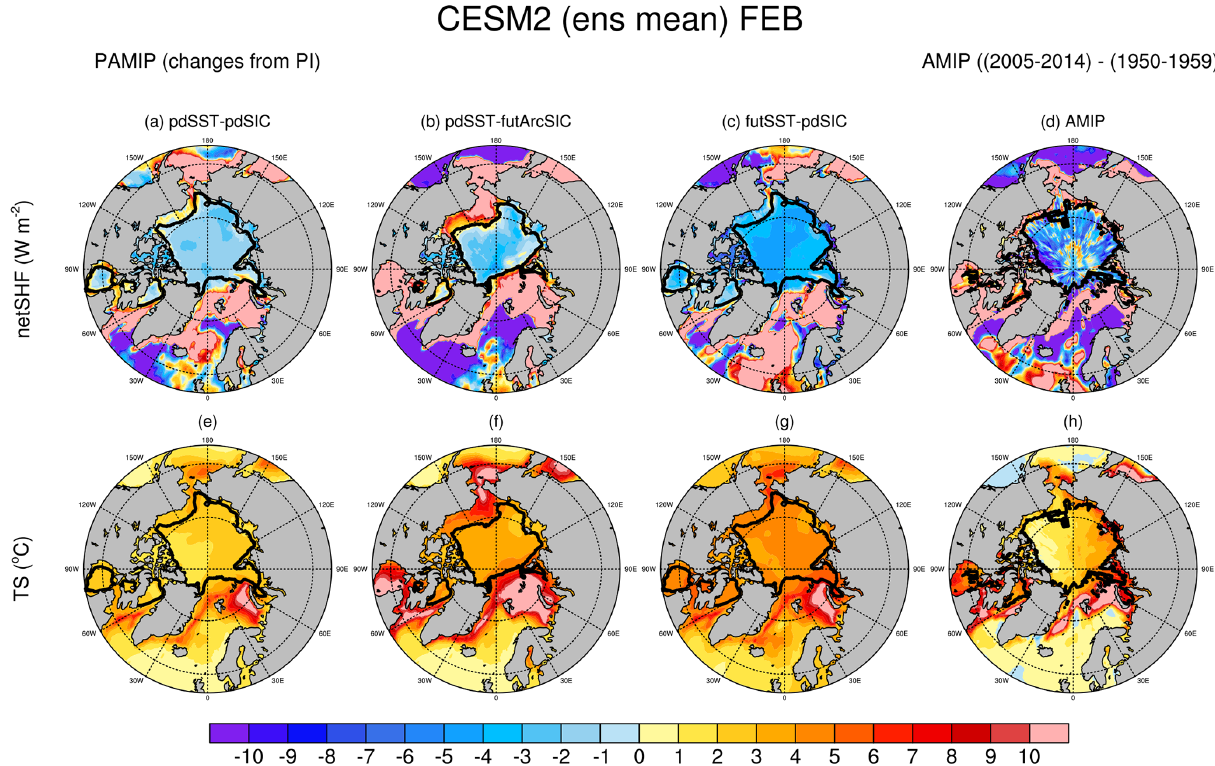
Figure 1. Changes in ensemble mean February net surface heat flux (netSHF; a–d ) and surface temperatures (TS; e–h ) for CESM2 PAMIP ( a–c , e–g ) and AMIP ( d, h ). PAMIP differences are from an 1850 pre-industrial control run where both SSTs (sea surface temperatures) and SICs are specified at 1850 levels. Differences from the pre-industrial (PI) control run are shown for PAMIP experiments with present- day SSTs and SICs (pdSST-pdSIC; a, e ), present-day SSTs and future SICs (pdSST-futArcSIC; b, f ), and future SSTs and SICs (futSST- futArcSIC; c, g ). AMIP simulations are from a 10-member ensemble, and differences shown are the ensemble mean of the final decade (2005–2014) minus the first decade (1950–1959) of the simulations. The 98% SIC contour is shown in black.